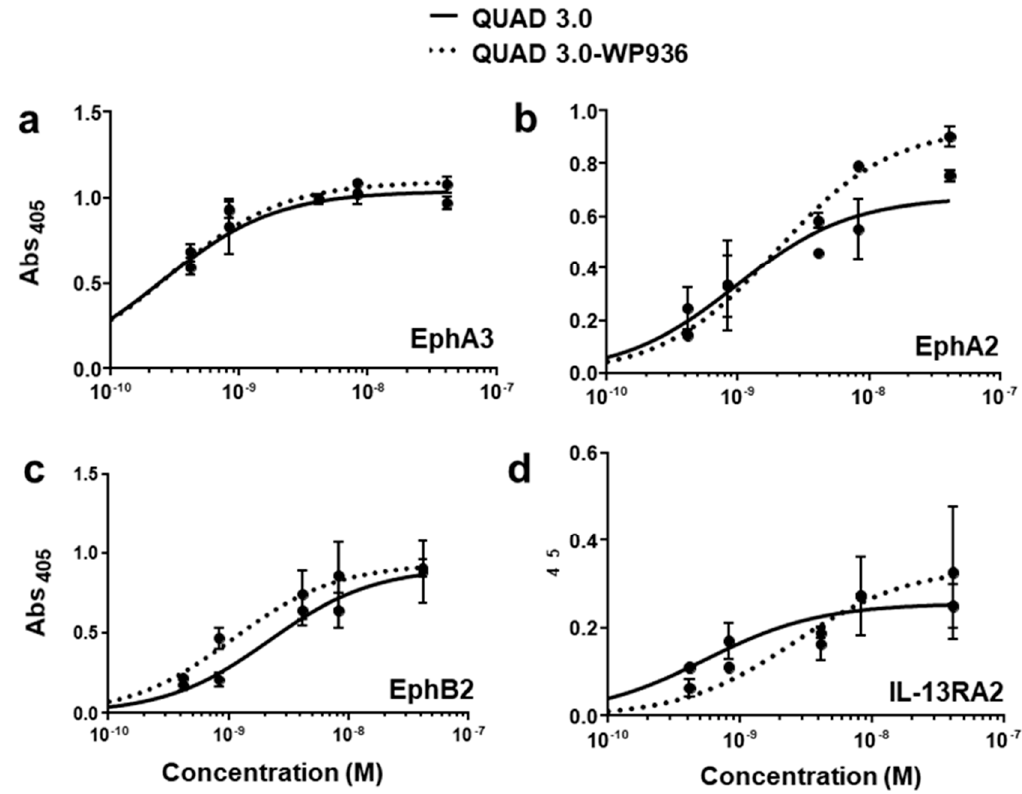
Figure 2. QUAD 3.0-WP936 binding to EphA3, EphA2, EphB2, and IL-13RA2 receptors. ELISA assay showing the binding of unconjugated QUAD 3.0 and QUAD 3.0-WP936 conjugate to ( a ) EphA3; ( b ) EphA2; ( c ) EphB2; and ( d ) IL-13RA2 receptor proteins. Table 1. Kd and Bmax values of QUAD 3.0 and the QUAD 3.0 Dox conjugates binding to the EphA3, EphA2, EphB2, and IL-13RA2 receptors. EphA3